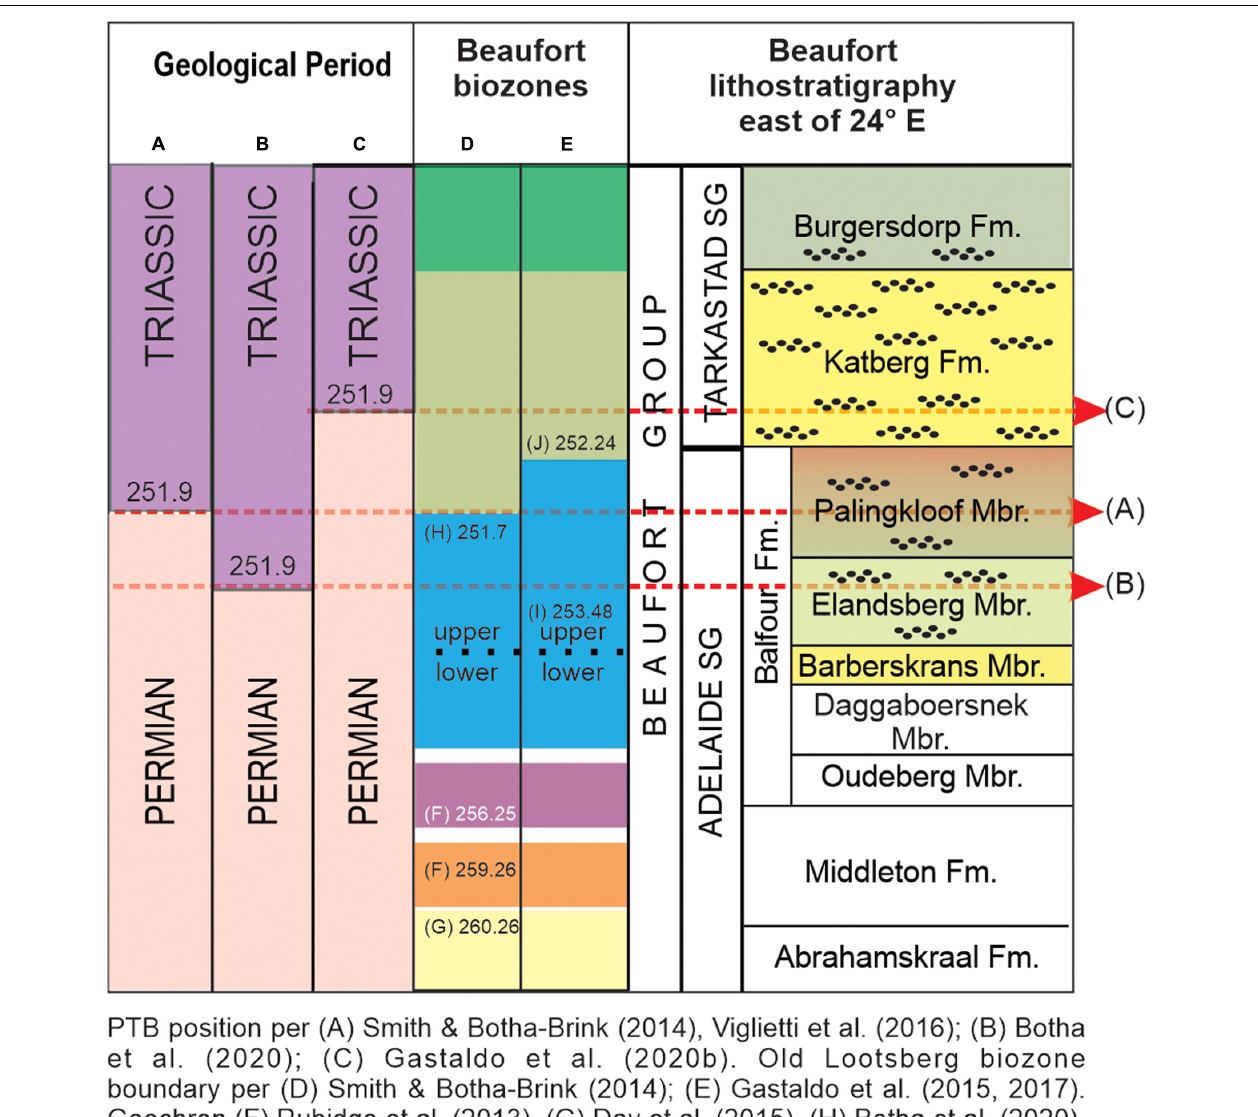
FIGURE 1 | General litho- and vertebrate biostratigraphy of the Upper Permian and Lower Triassic succession, Karoo Basin, South Africa, with constraining geochronometric age assignments. The boundary between the Daptocephalus and Lystrosaurus Assemblage Zones is interpreted by several workers (A) as equivalent with the end-Permian event (dashed red line) in the oceans. Recently, an Early Triassic detrital zircon age has been published for the Daptocephalus AZ (B) , implying that the biozone boundary has to be moved into the Mesozoic. In contrast, geochronometric constraints published for the Daptocephalus and Lystrosaurus AZs from ashfall deposits (C) restrict both to the latest Permian, demonstrating that the biozone boundary is not coincident with the marine extinction event. All workers place this boundary in the uppermost Balfour Formation, although Gastaldo et al. (2015, 2017, 2018) place the boundary higher (E) at Old Lootsberg Pass than (D) Smith and Botha-Brink (2014). We follow the scheme of Gastaldo et al. (2018, 2020a). The distribution of intraformational pedogenic nodule conglomerate ranges from the Elandberg Member to the Burgersdorp Formation. All dates are in Ma.